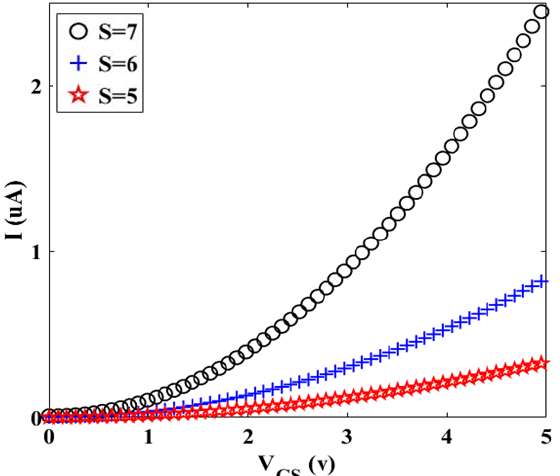
Figure 9. I- VGS characteristic for different values of S at room temperature (Z = 10).